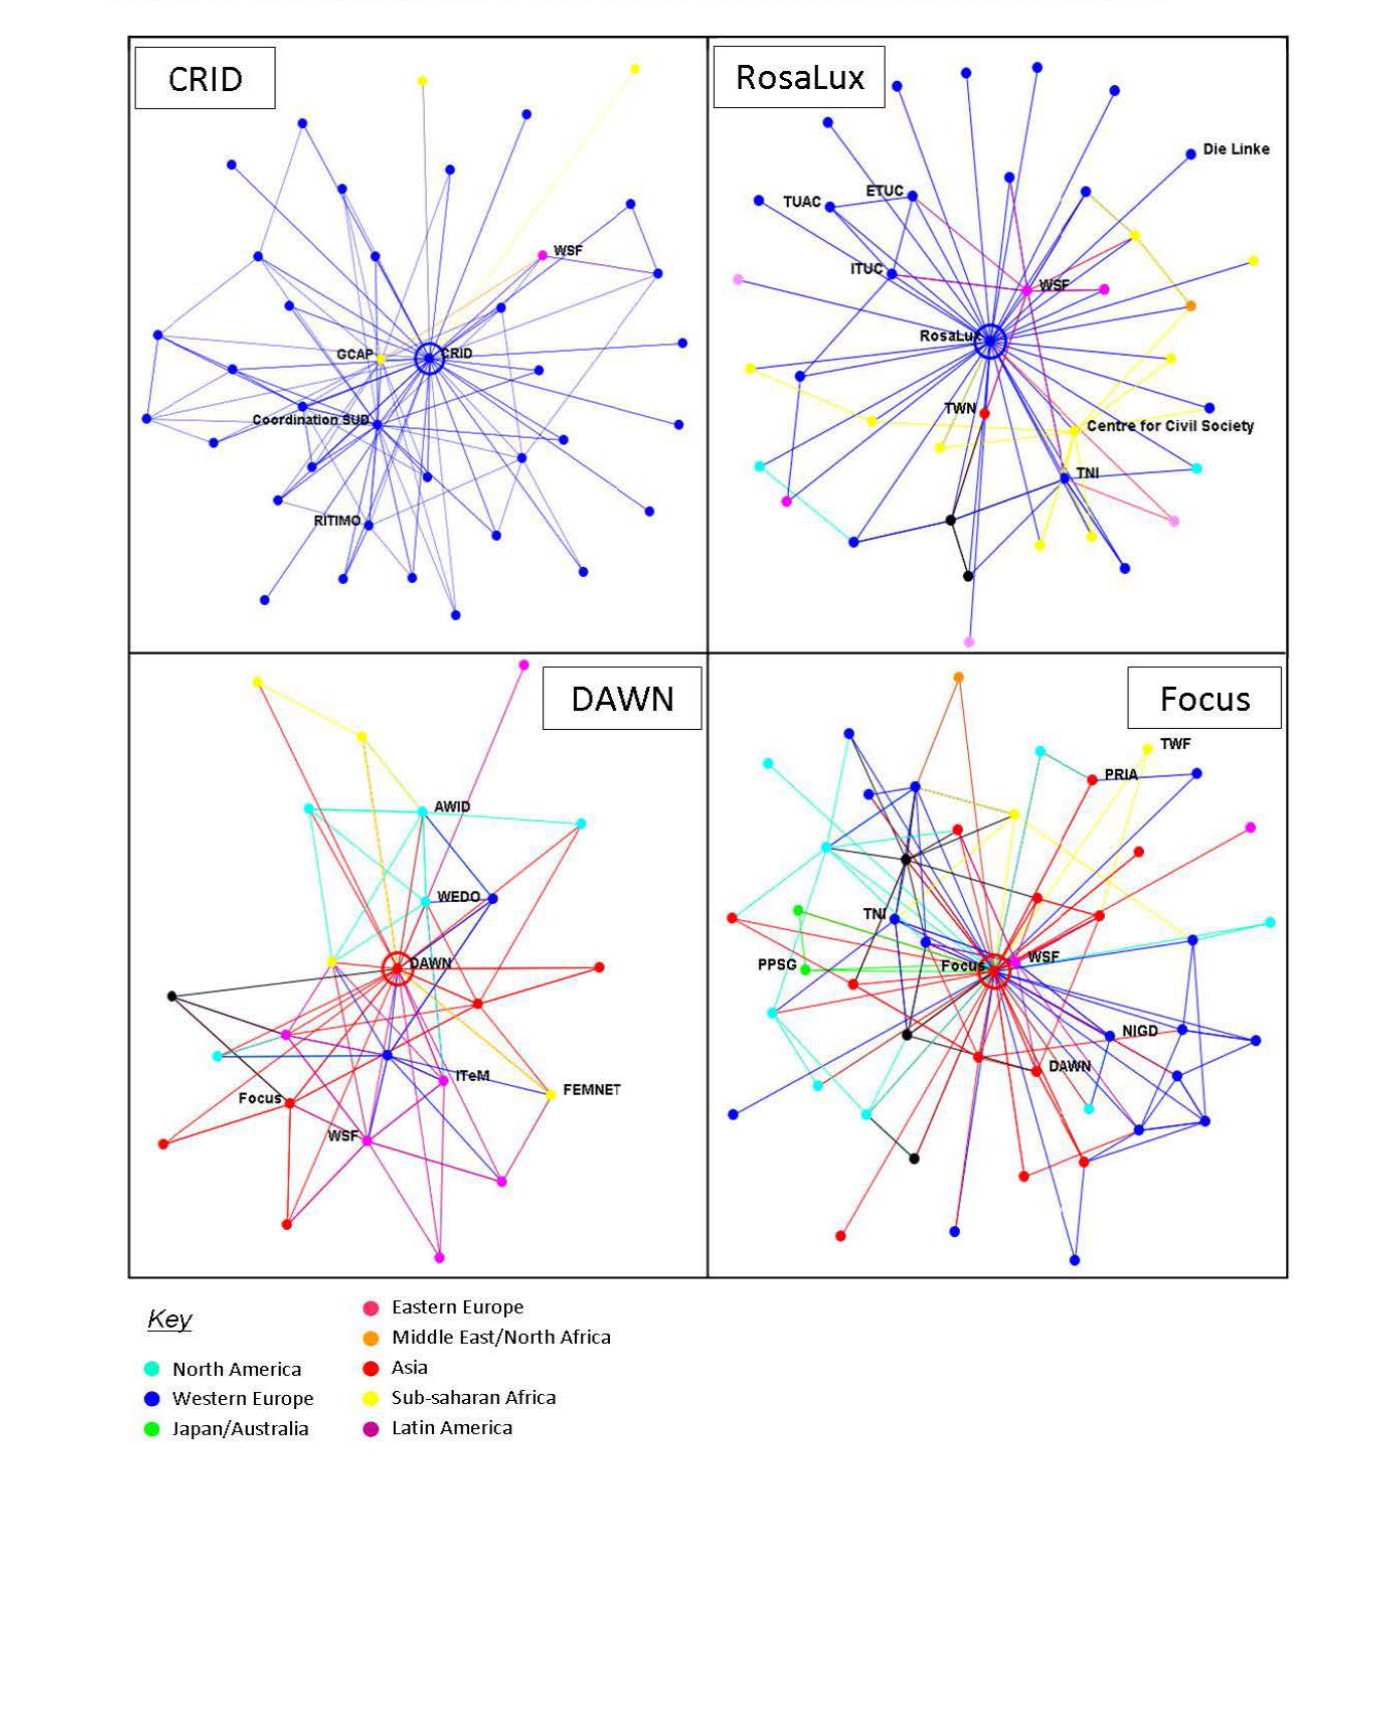
Figure 4. Embeddedness of four key TAPGs within their respective neighborhoods